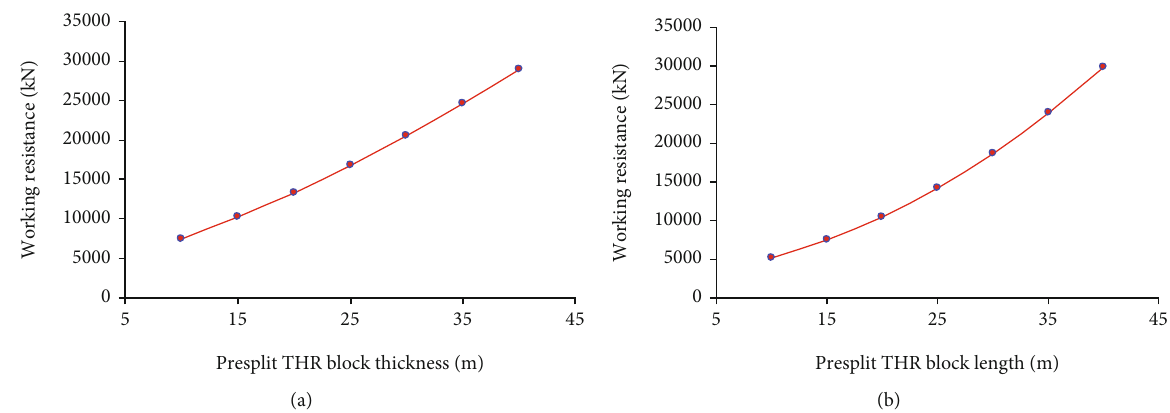
Figure 7: Relationship between support working resistance and size of blasting presplitting block.